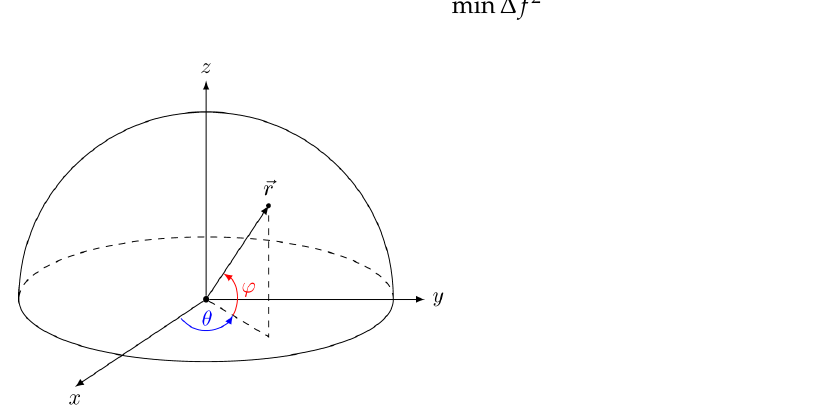
Figure 3. Spherical coordinate system. A point on the hemispherical surface is determined by the longitude angle θ i and the latitude angle ϕ i